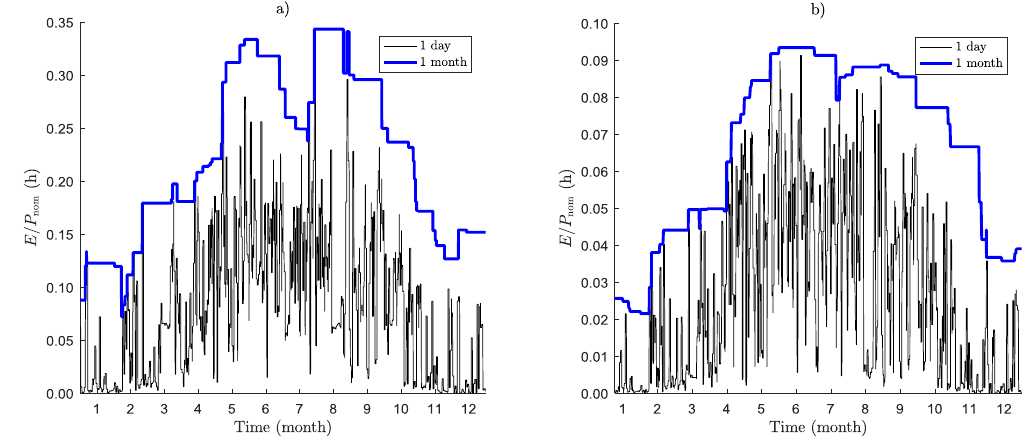
Figure 4. Required ESS energy capacities for ( a ) 60 min and ( b ) 15 min ISP times shown at the end of the observation periods of 1 day and 1 month for the 0.1 MW PV plant in 2015.